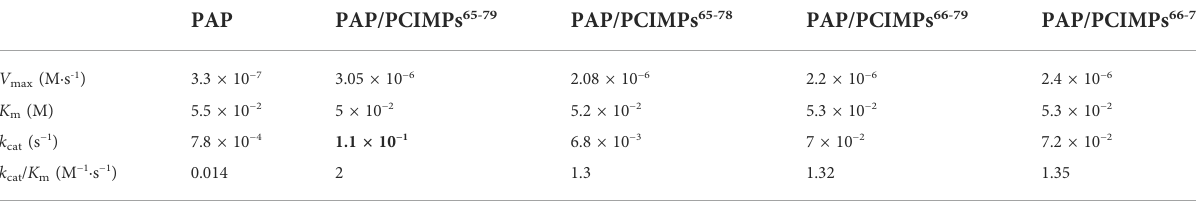
TABLE 3 Kinetic parameters obtained from the Michaelis – Menten kinetics plot.